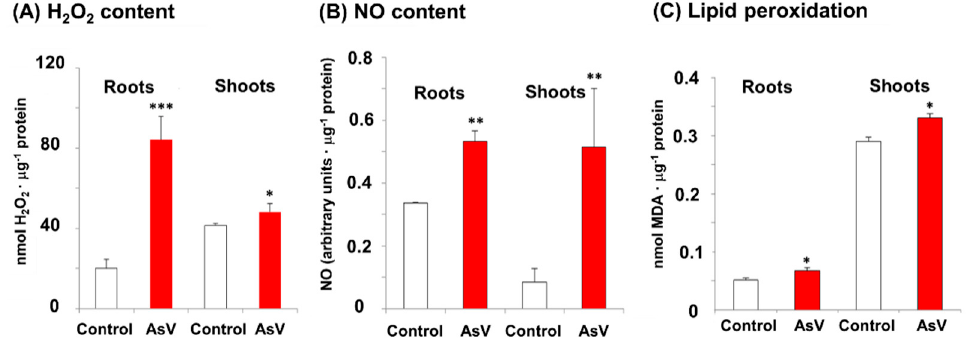
Figure 8. Levels of hydrogen peroxide, lipid peroxidation and nitric oxide in roots and shoots of 26-d-old rice seedlings grown in hydroponic solutions supplemented the last 12 days without (control) and with 50 µ M AsV. ( A ) Hydrogen peroxide (H 2 O 2 ) content. ( B ) Nitric oxide (NO) content. ( C ) Lipid peroxidation level. Data represent the mean ± SEM of at least three di ff erent experiments. t-Student was used to compare data from As-treated plants with control ones. Asterisks indicate that di ff erences with respect to control (0 µ M AsV) values were statistically significant at p < 0.05 (*), p < 0.01 (**) and p < 0.001 (***).